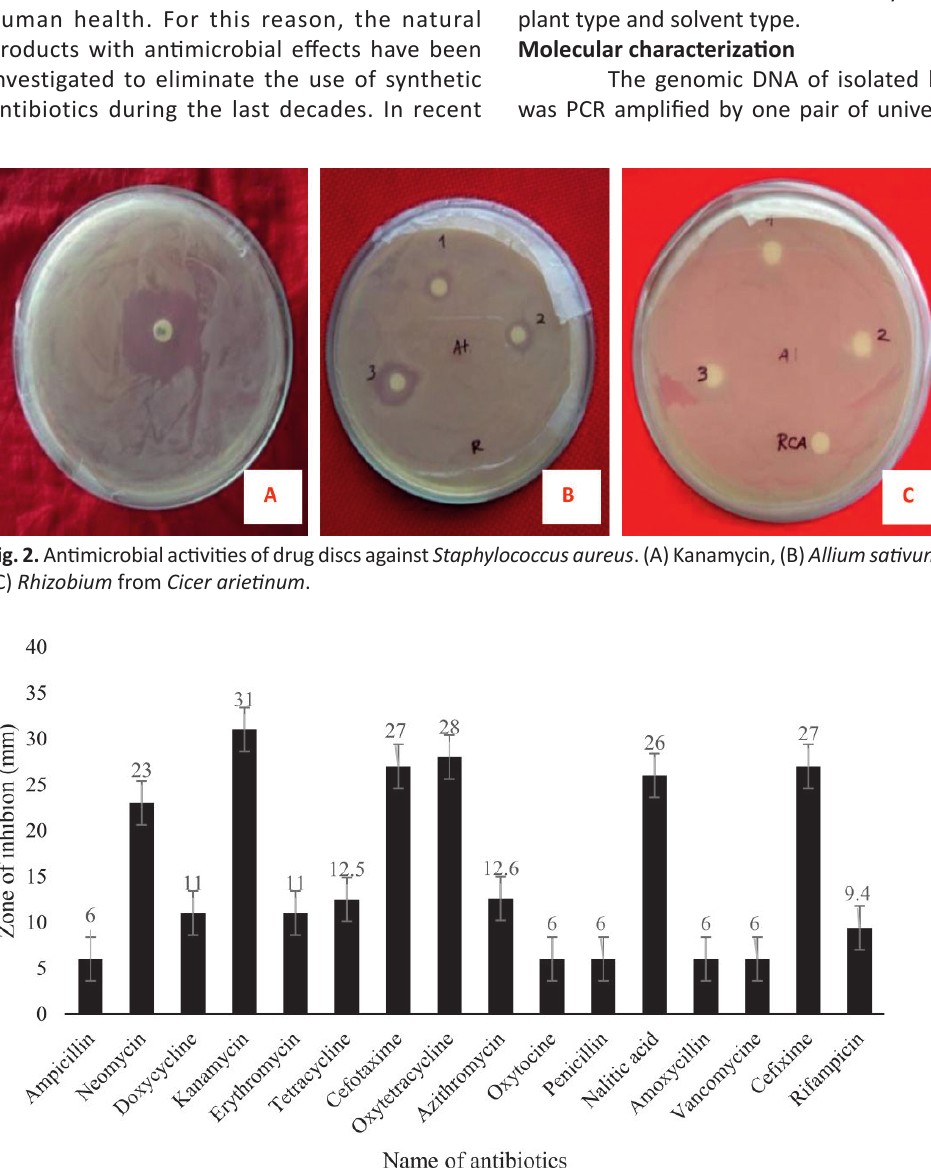
Fig. 3. Graphical representation of antibiotics and their zone of inhibition Legend: M±SE=mean and standard error, Resistant=<10 mm; Intermediate =10-15 mm; Susceptible=>15